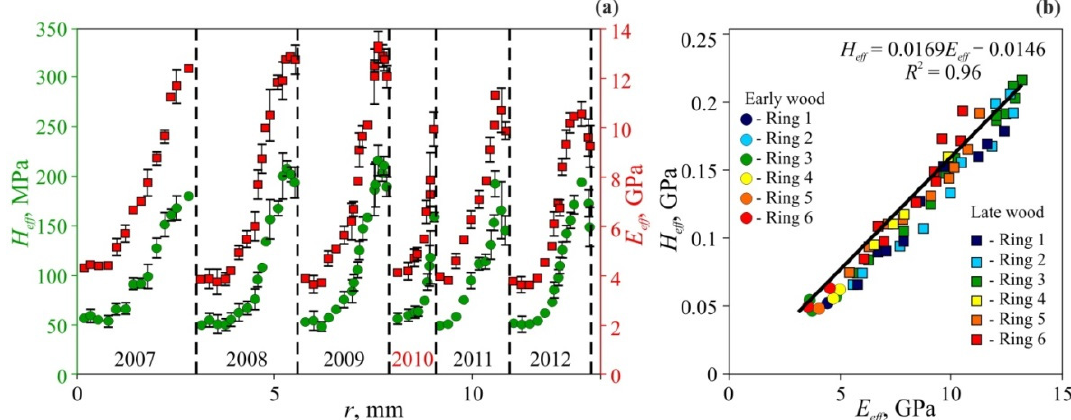
Figure 10. Micromechanical properties of common pine annual growth rings measured at P max = 500 mN [116]. ( a ) Spatial dependencies of H eff and E eff over radial distance r for six successive rings. Ring boundaries are shown using dashed lines. The extraordinarily draughty 2010 year is highlighted by red color. ( b ) Dependence of hardness H eff upon Young modulus E eff for six successive rings.